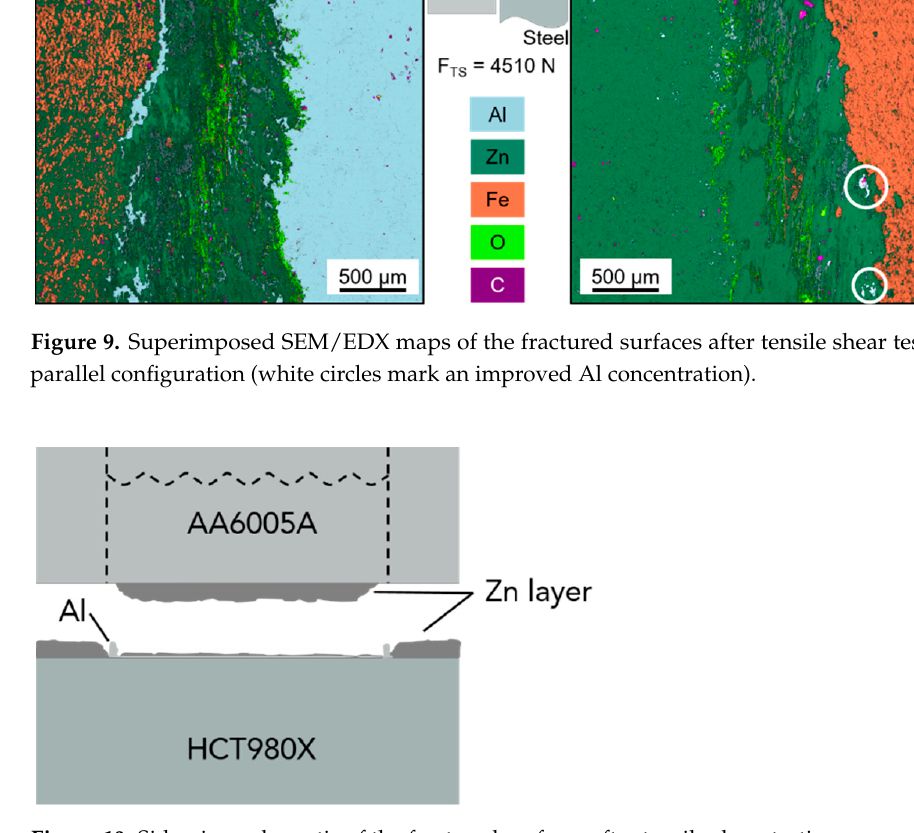
Figure 10. Side-view schematic of the fractured surfaces after tensile shear testing.